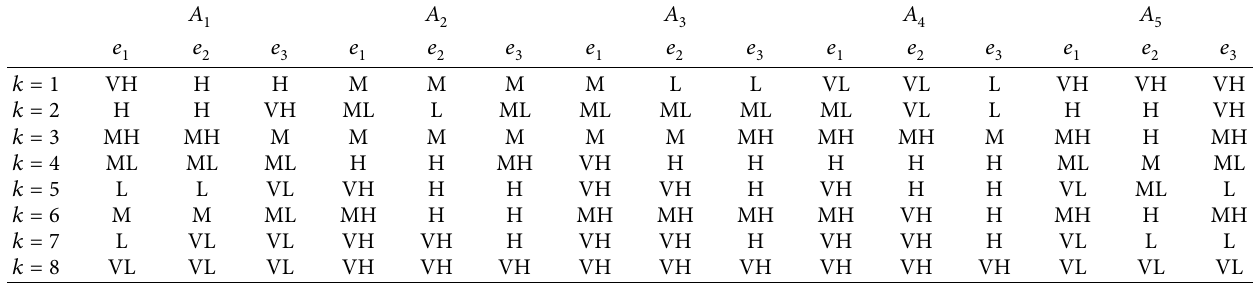
Table 15: LSI logistics service capability scoring information when decoupling points are in different positions: scoring by the expert judgment method.